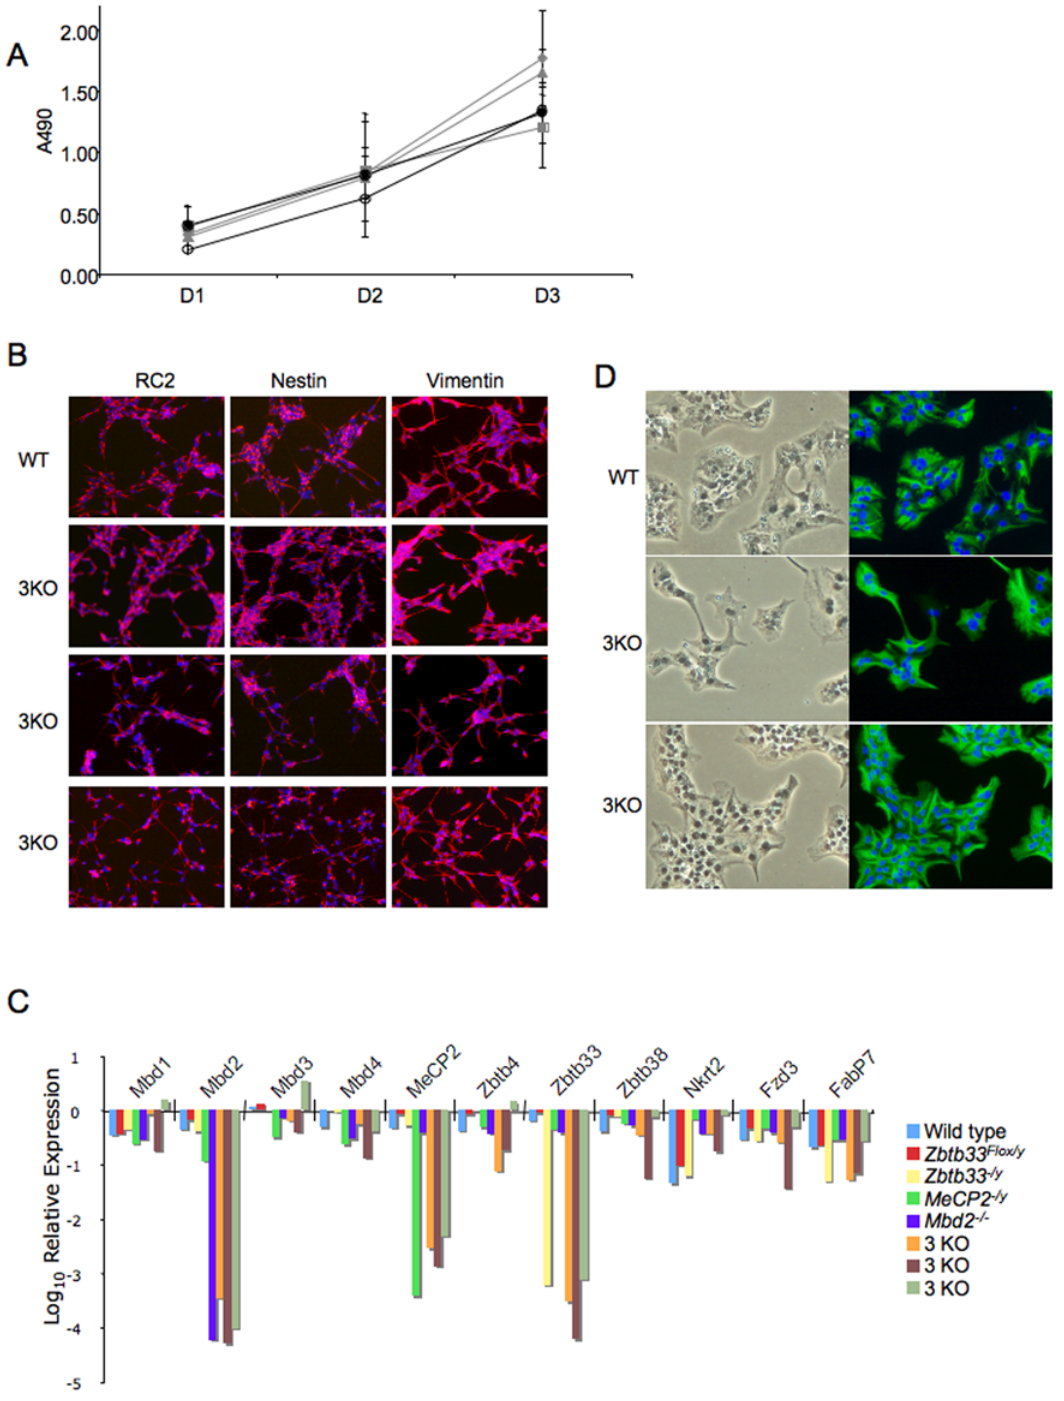
Figure 4. 3KO Neural stem cells. A. Proliferation rates of three 3KO NS cell lines (grey lines) and two wild-type NS cell lines (black lines) were measured by the MTT assay over three days. Error bars represent SEM. B. Immunocytochemistry of the indicated NS cell markers (red staining) in one wild-type NS cell line (top panels) and three independent 3KO NS cell lines. Cells were counterstained with Dapi (blue). C. Expression levels of the genes indicated across the X-axis were measured in wild type, single mutant, and triple mutant NS cell lines (as indicated in the legend). Expression was monitored in triplicate in two biological replicates by quantitative PCR, and results of a representative experiment is shown. Expression levels were normalized to Sox2 expression and are shown relative to the levels found in an E14.5 cortex-derived wildtype NS cell line. The Zbtb33 2 /y NS line was made by Cre transfection of the Zbtb33 Flox/y NS line, as described [24], while the remaining mutant NS lines were all derived from E14.5dpc embryos. D. Immunostaining of NS cell cultures after four days in the presence of serum and removal of growth factors to induce Gfap activation. Left panels: bright field, right panels: Gfap (green), Dapi (blue). Top panels: WT cells, middle and bottom panels: two independent 3KO cell lines.